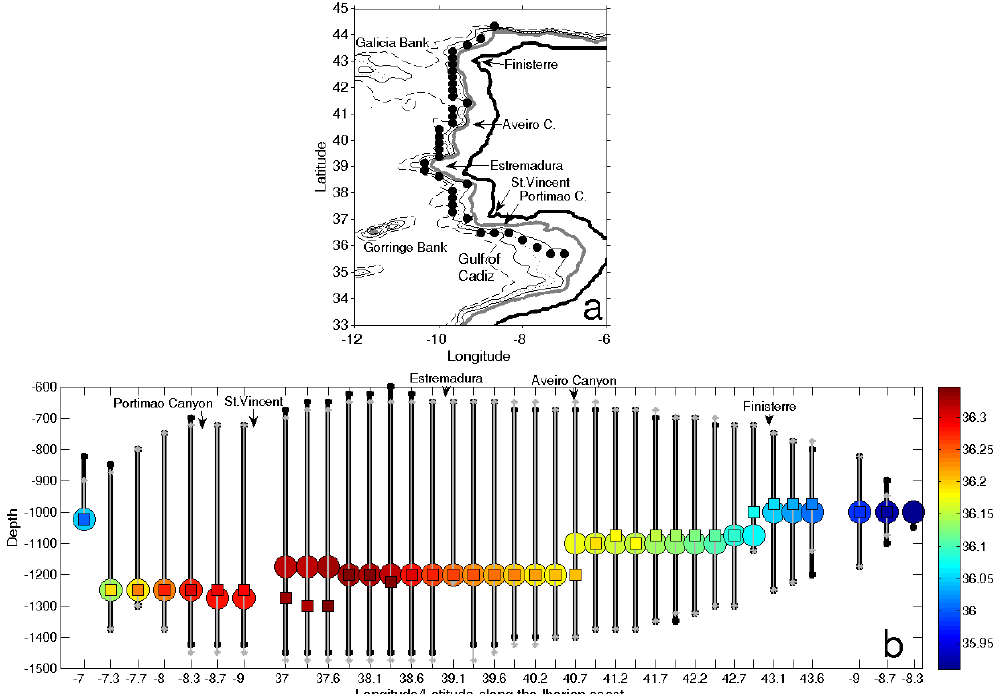
Figure 14. (a) Positions of the axis of the lower MW core derived from the MEDTRANS data set (black dots), overlaid on bathymetry of the Iberian–Canary basins. (b) Seasonal variations of the depth and salinity of the lower MW core along the Iberian slope in the cold season (disks) and warm season (squares). The vertical segments represent the maximum depth limits of S ≥ 0 . 99 × S max at the